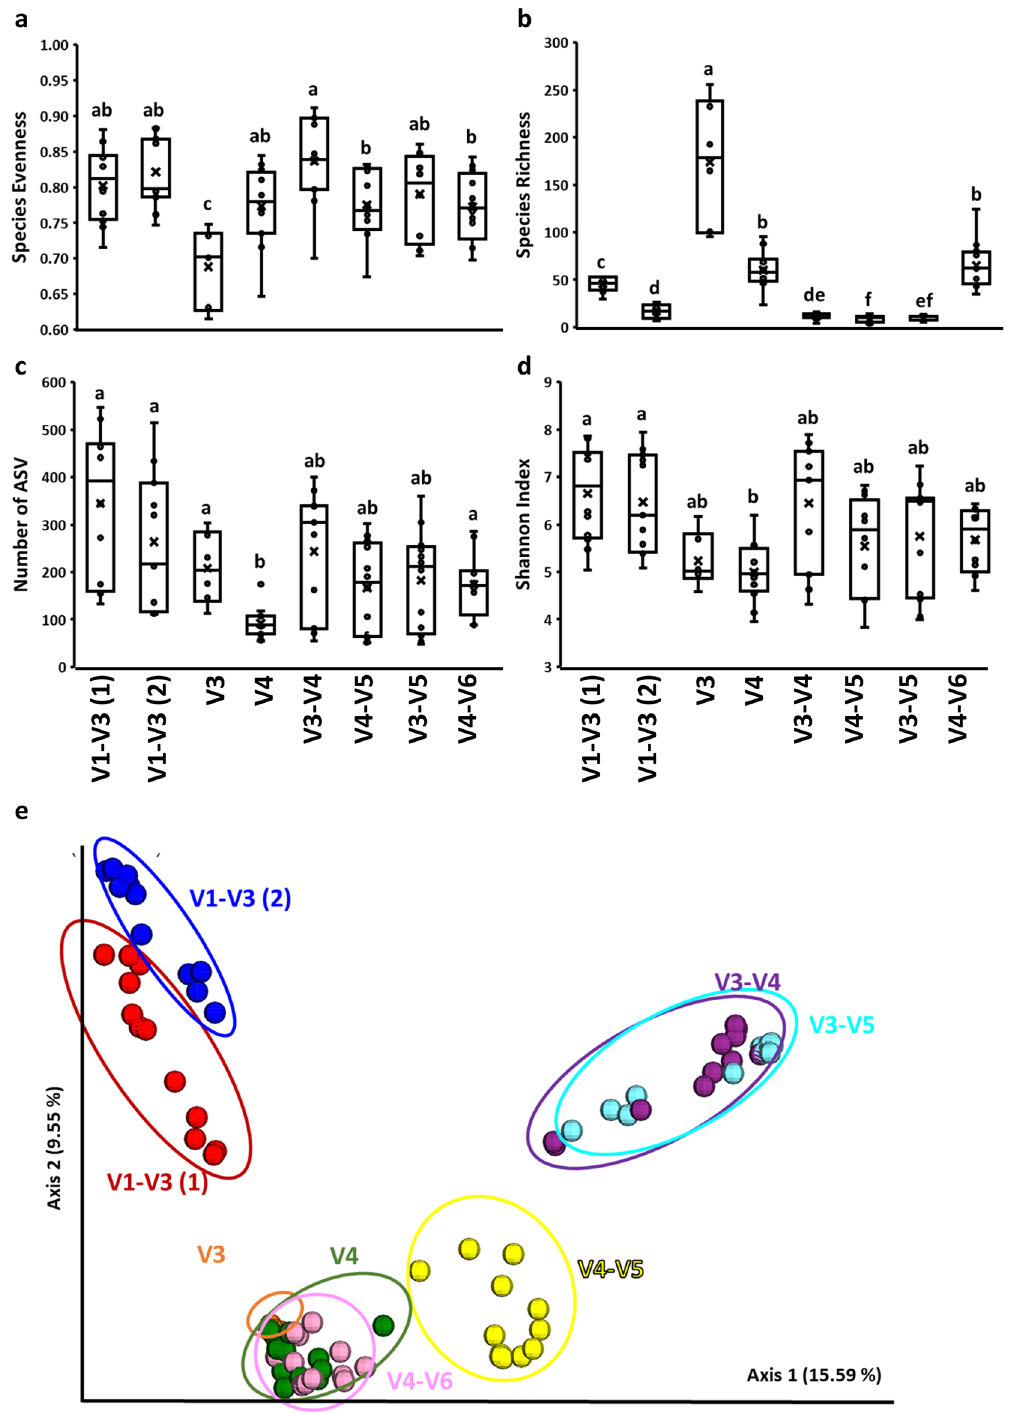
Figure 1. Effect of primer set on alpha (a–d) and beta (e) diversities in cecal microbiota. Alpha diversities indices: (a) Evenness, (b) Richness, (c) ASV number, and (d) Shannon index. (e) Principal coordinate analysis (PCoA) based on unweighted pairwise UniFrac distances between primer sets in cecal microbiota. a,b,c,d,e,f q < 0.05 (q represents p value corrected for false discovery